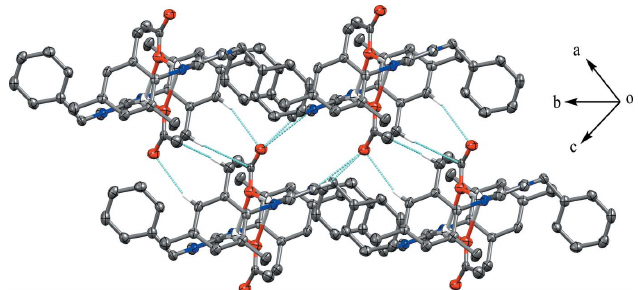
Figure 3 Intercalation of two-dimensional sheets via C—H (cid:4)(cid:4)(cid:4) O and C—H (cid:4)(cid:4)(cid:4) C short interactions in complex 2